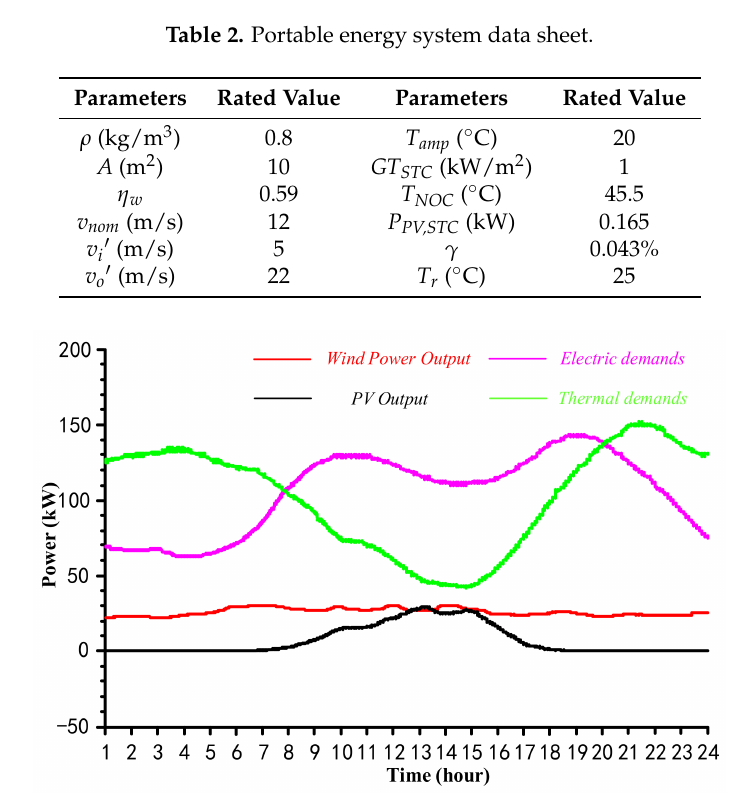
Figure 2. The Monte Carlo simulation results of the renewable system outputs, thermal demands, and electrical